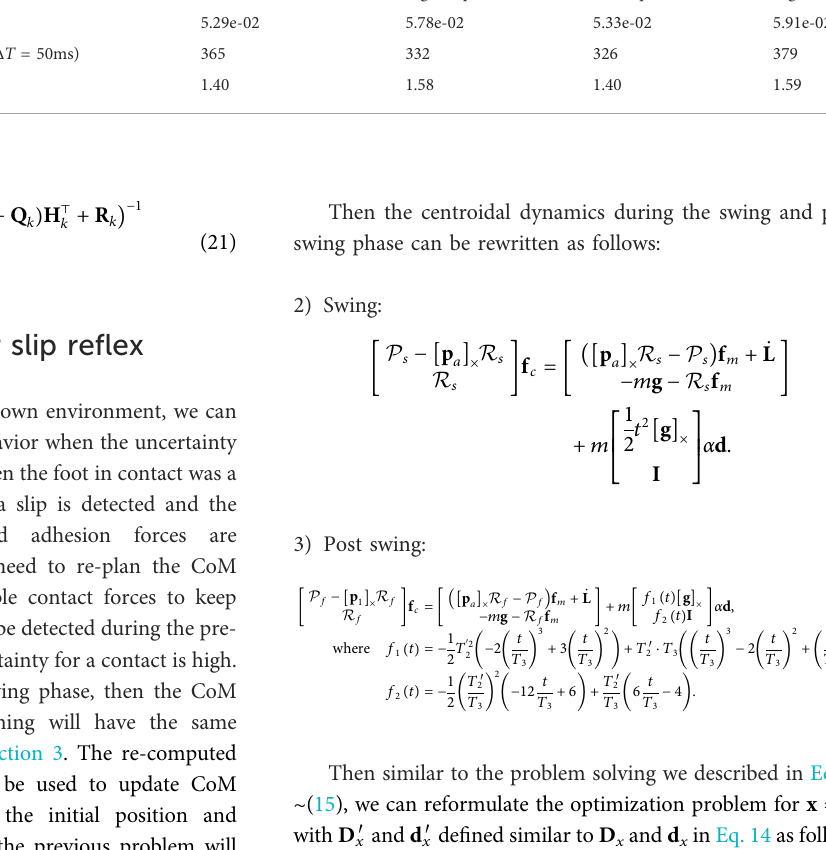
Swing foot Left bottom Right top Left top Right bottom Proposed